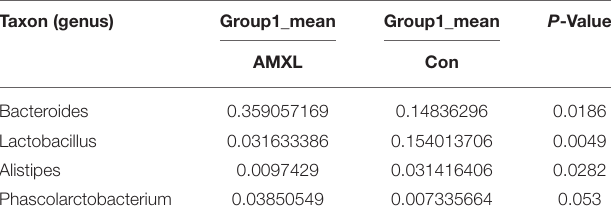
TABLE 6 | Based on Metastats analysis for flora differences between AMXL and Con groups under the genus. Taxon (genus)